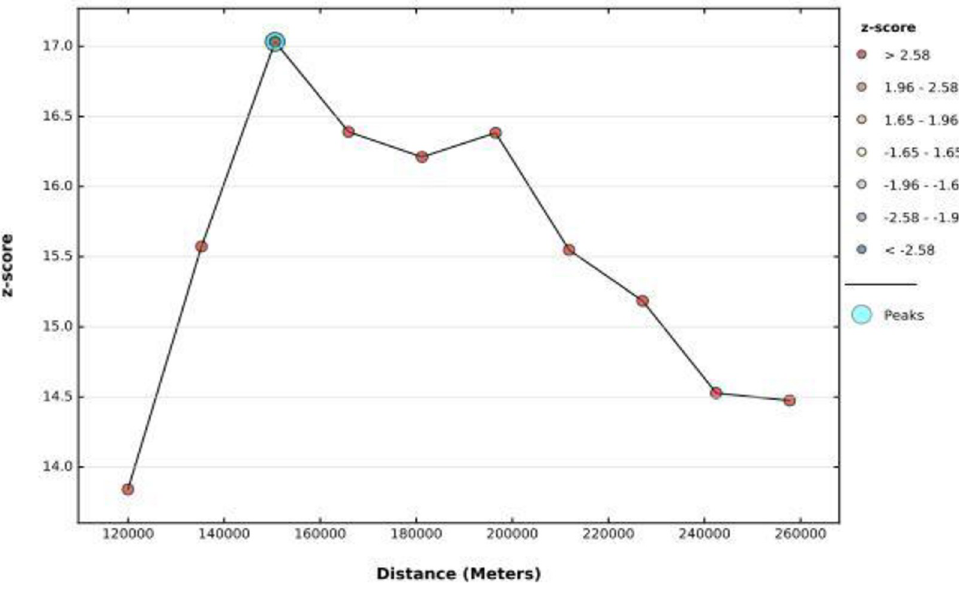
Fig 1. The spatial autocorrelation of poor consumption of foods rich in vitamin A among children aged 6–23 months in Ethiopia.